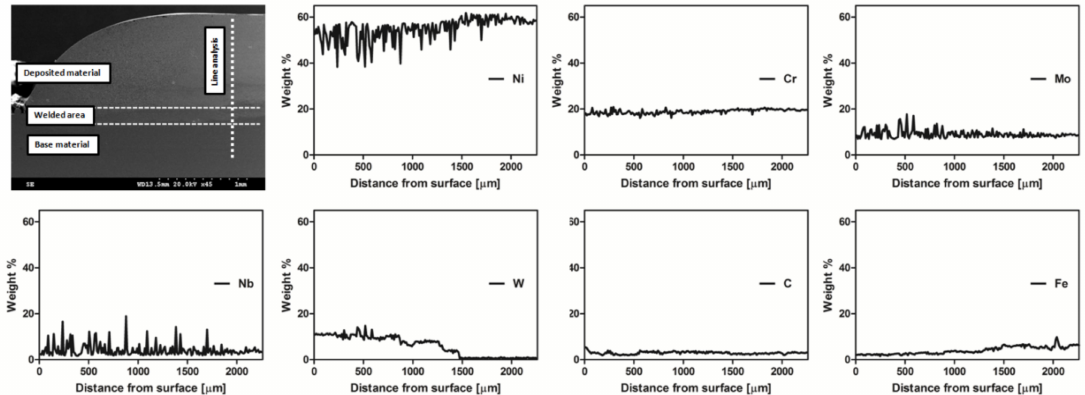
Figure 7. SEM images showing edge of prepared MMC